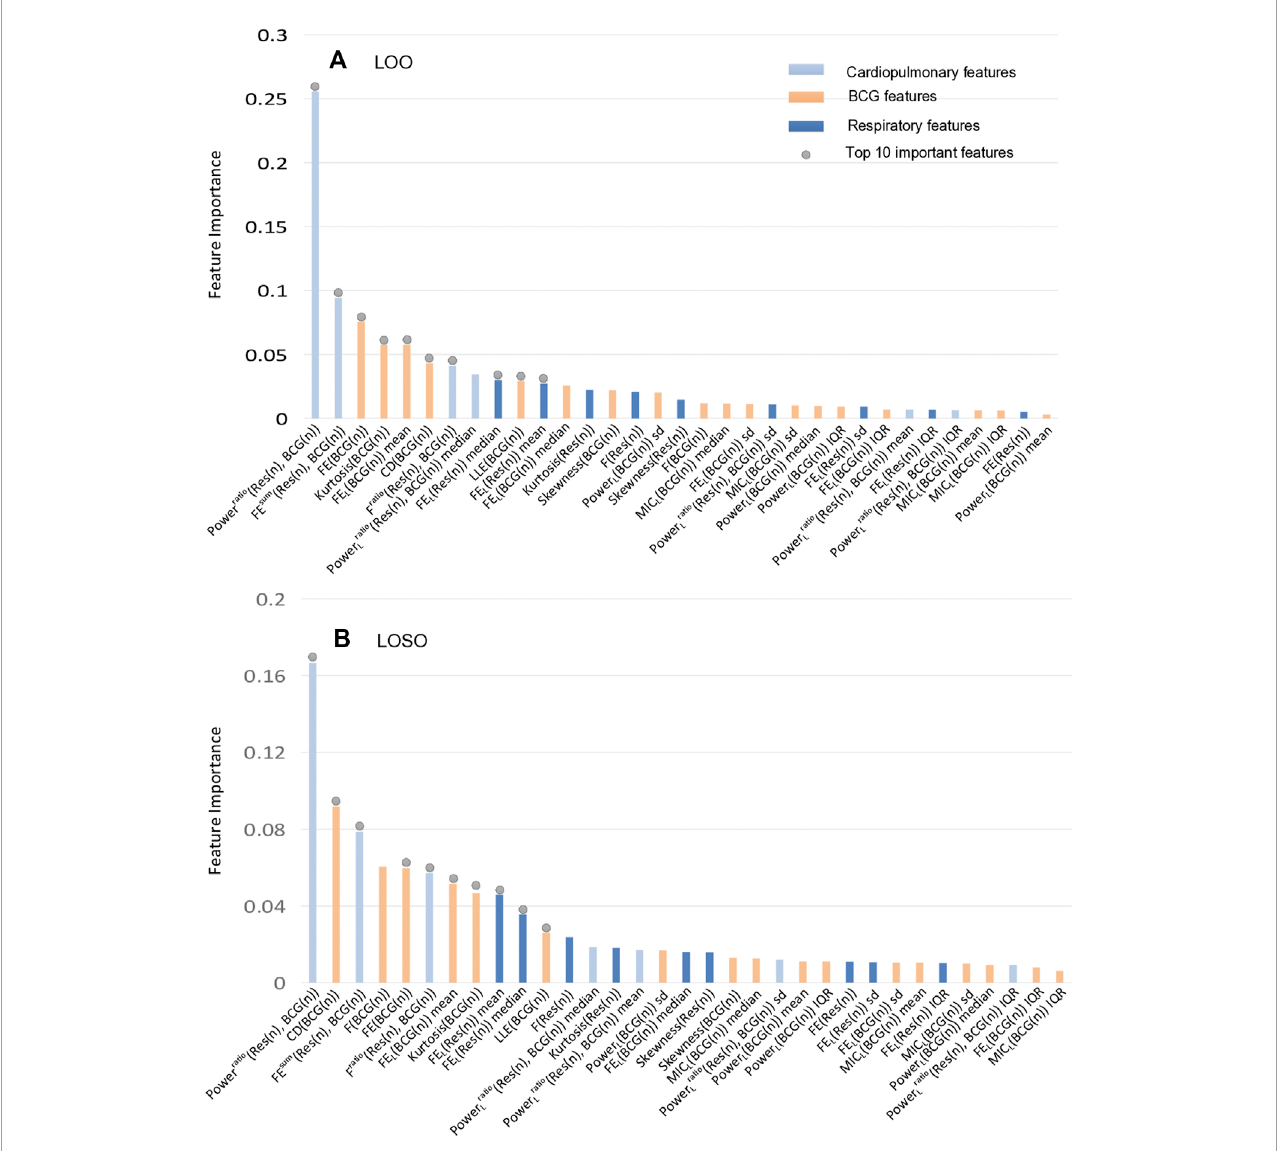
FIGURE 6 The importance ranking of all features in the XGBoost model under LOO and LOSO. The together top 10 important features contribute 71.00% and 65.88% to the classification, respectively. (A) The importance ranking of classifier features in LOO settings. (B) The importance ranking of classifier features in LOSO